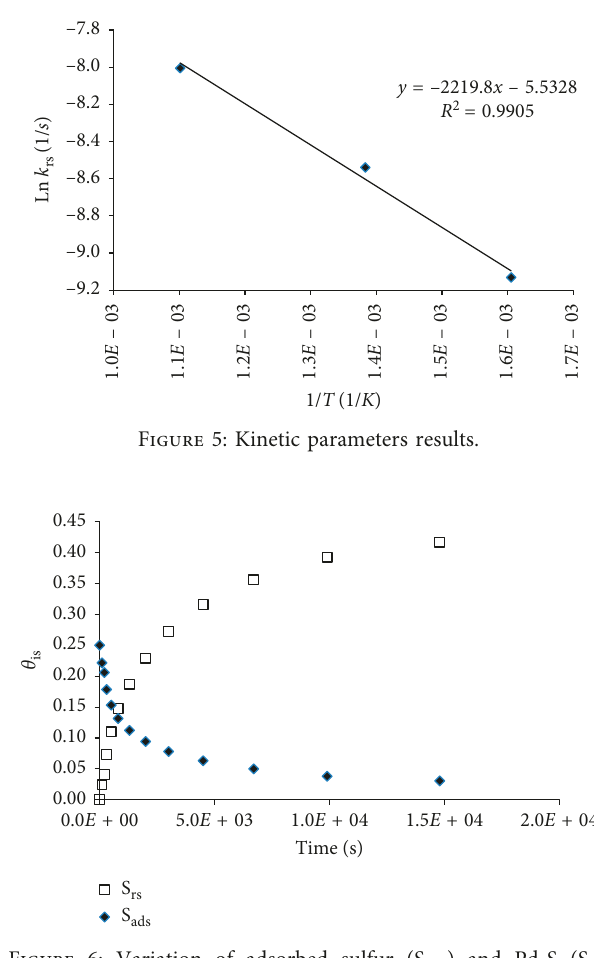
ads ) and Pd 4 S (S rs )